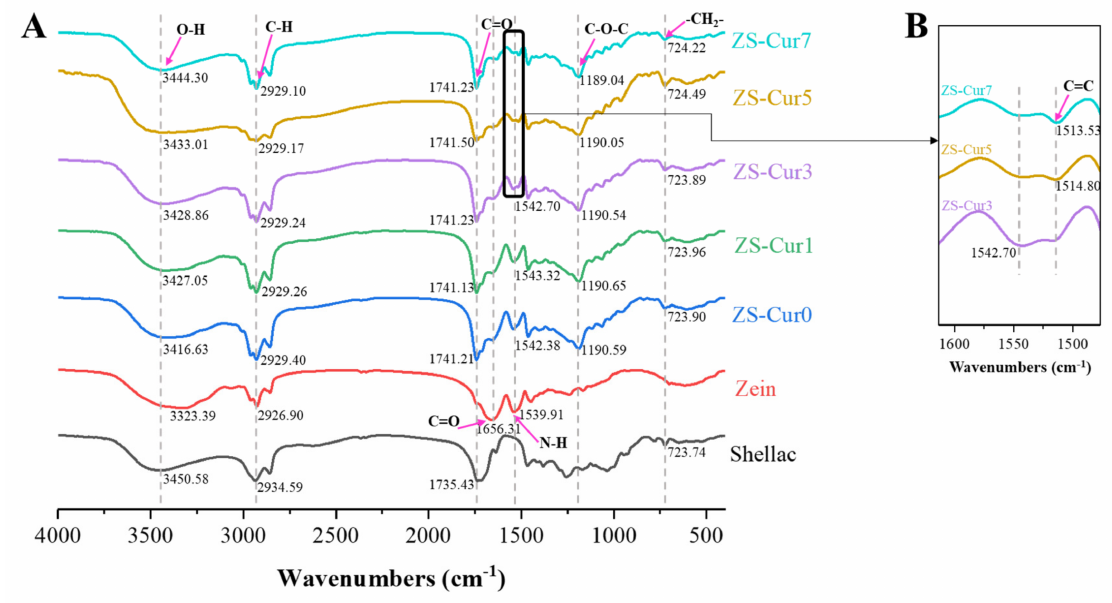
Figure 3. FT-IR spectra of zein/shellac films loaded with curcumin; ( A )—FT-IR spectrum of pure shellac curcumin; ( B )—FT-IR spectrum of pure shellac with increased curcumin